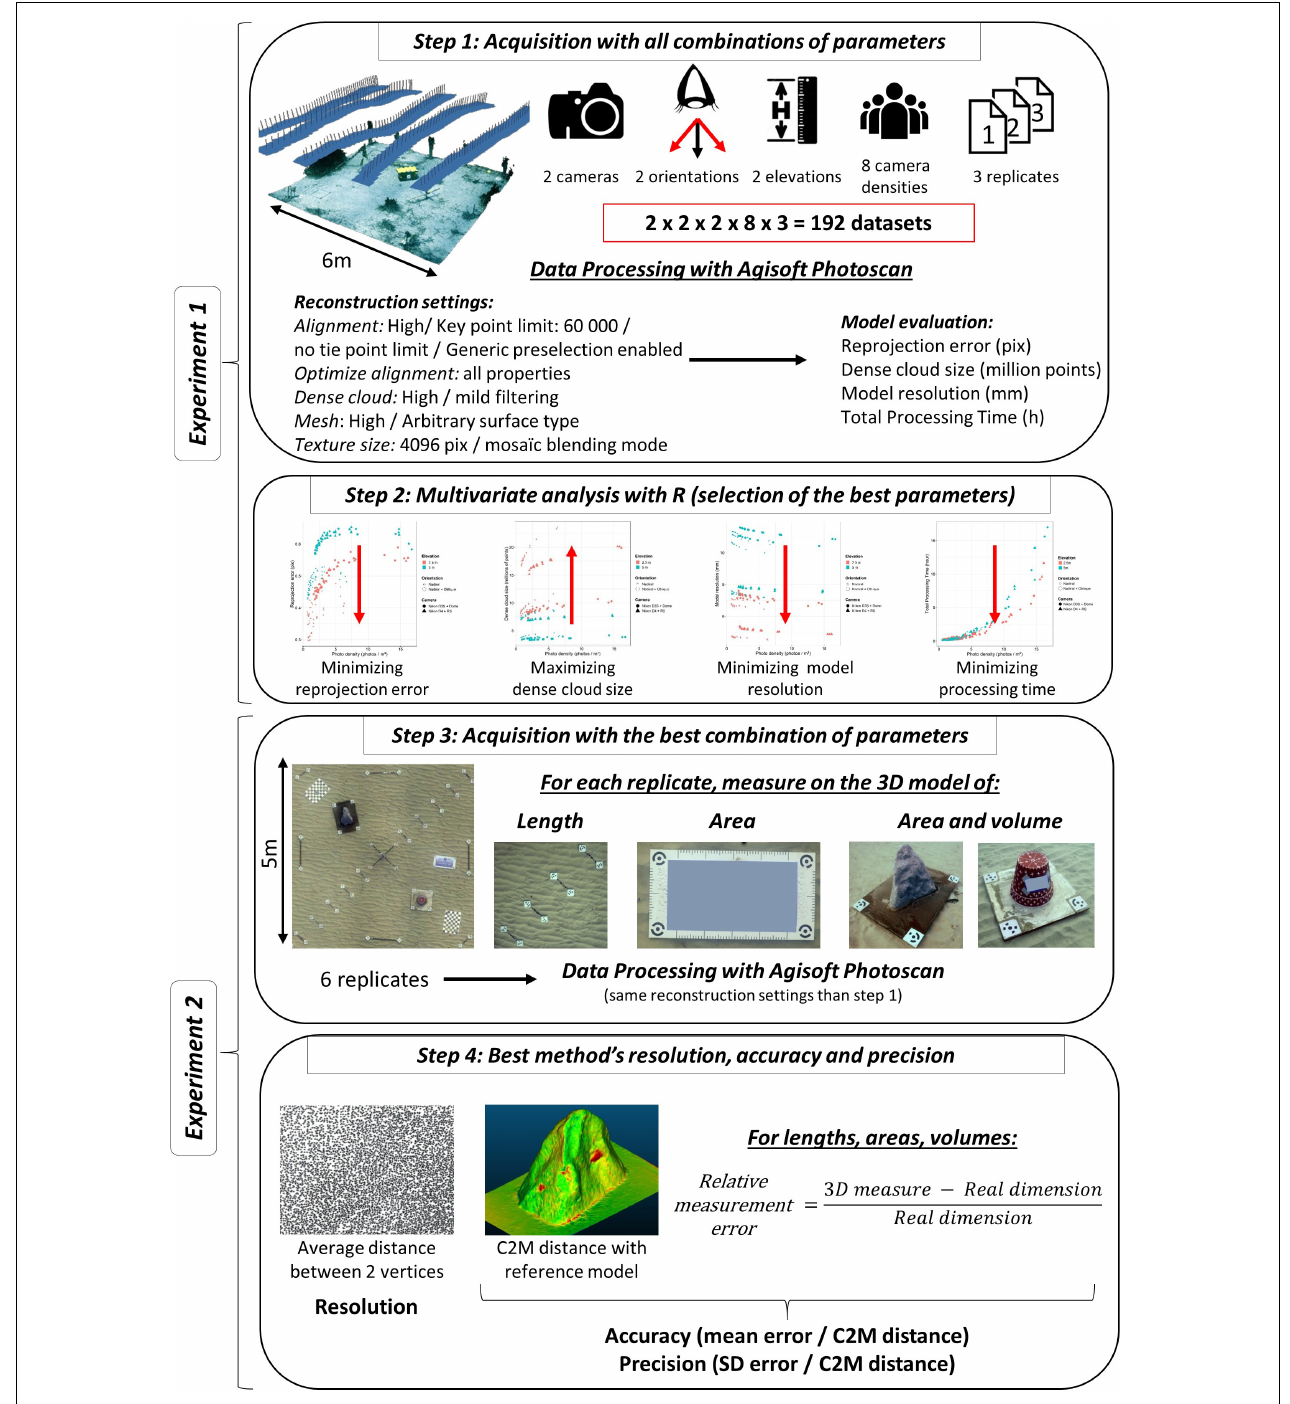
FIGURE 1 | Flow diagram of the methodology. C2M,